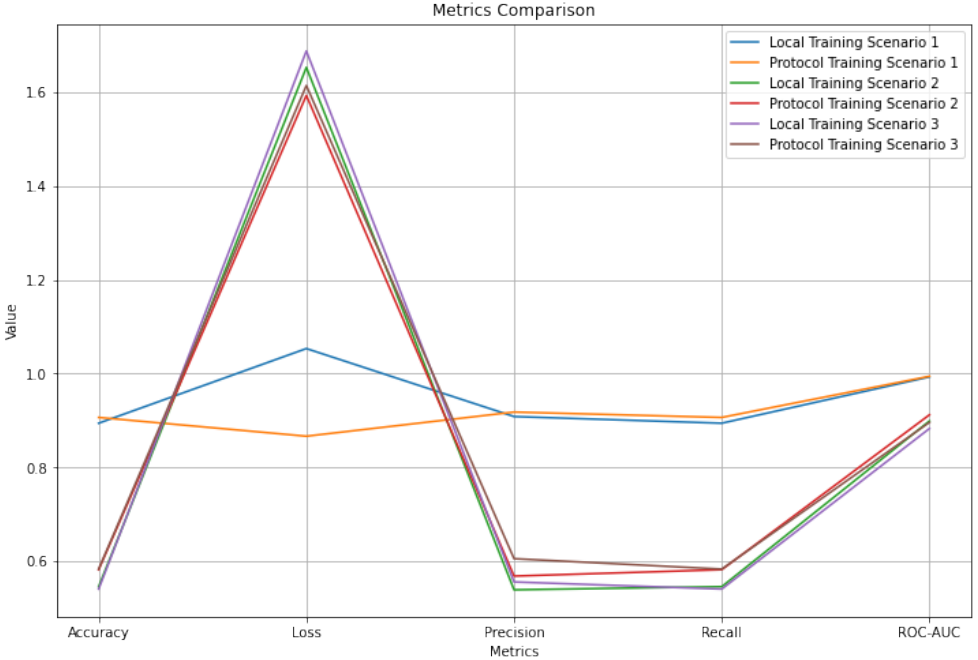
Figure 10. Comparison of average metrics for all scenarios.